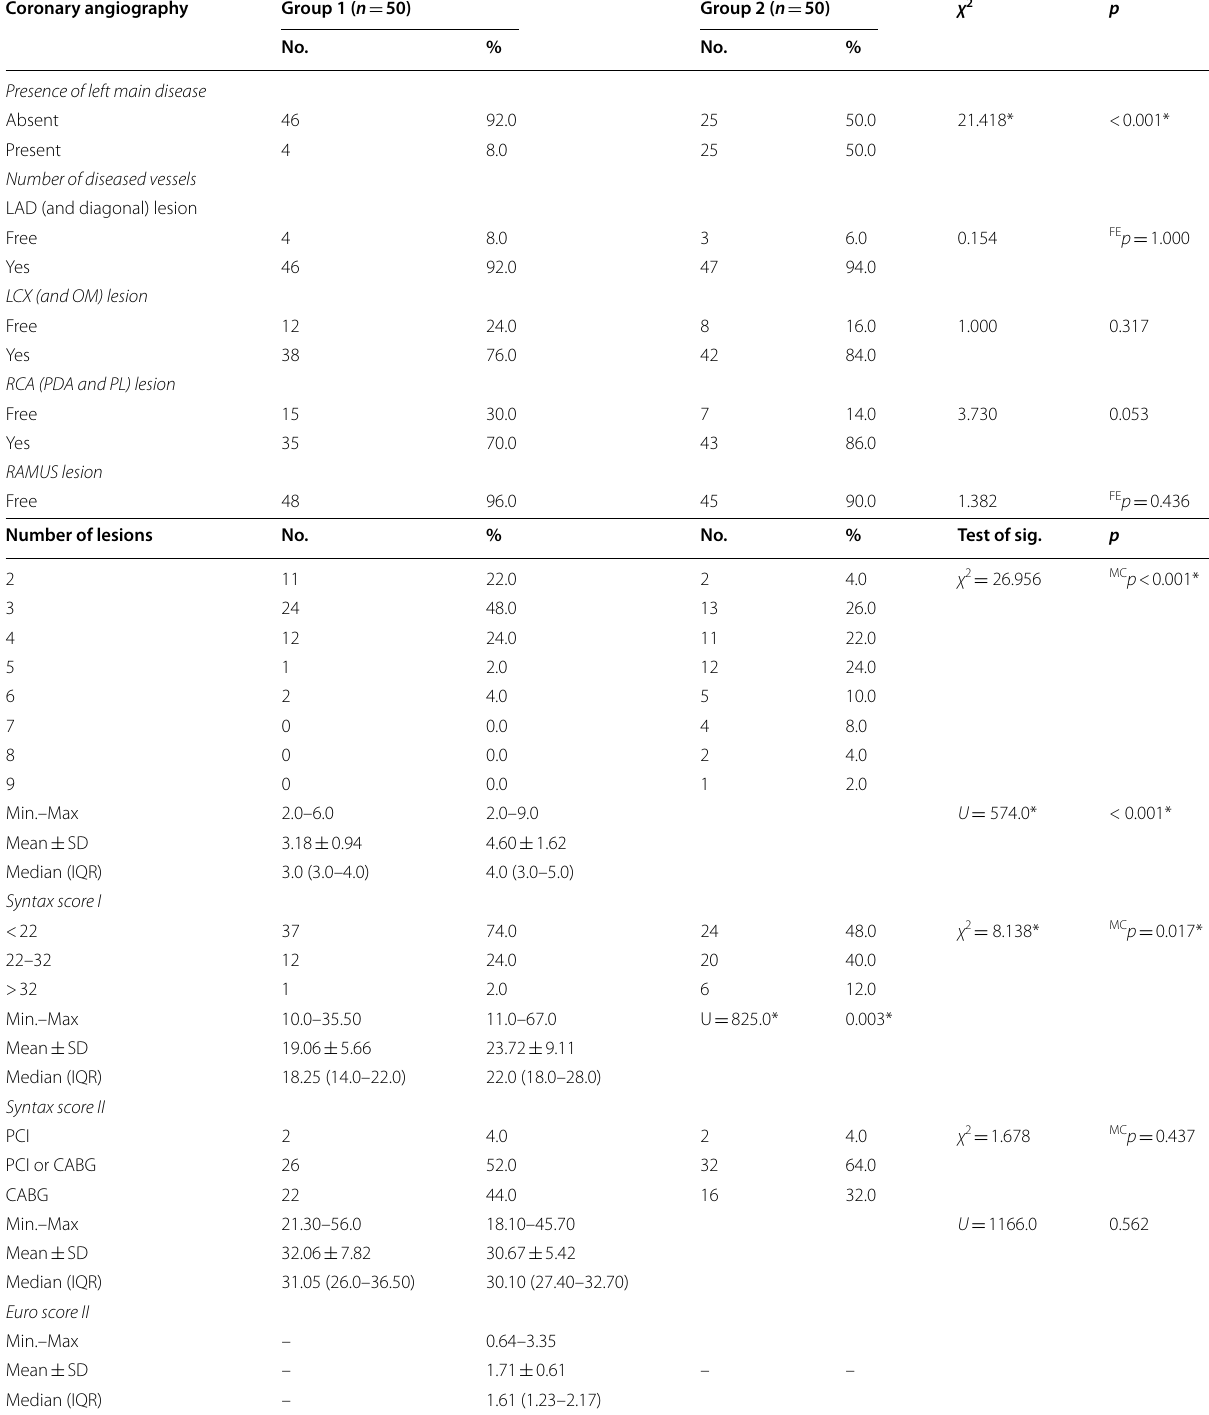
Table 4 Two studied groups compared in accordance with coronary angiography